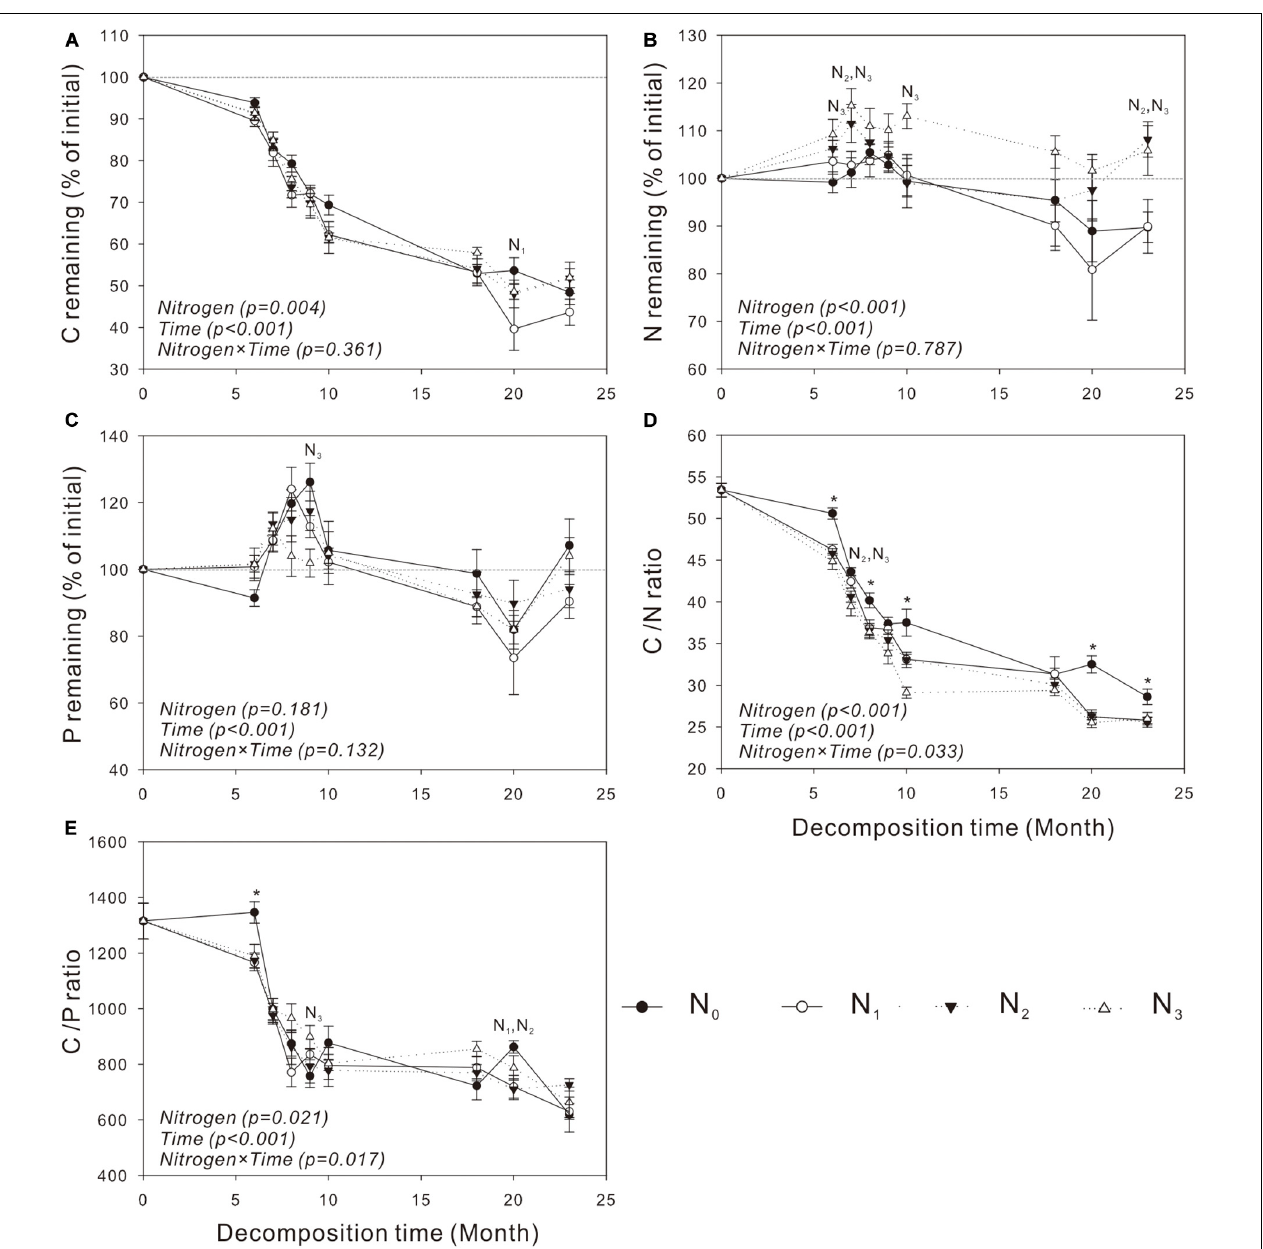
FIGURE 3 | Dynamics of the remaining C, N, and P and the C/N and C/P ratios in leaf litter of Spiraea trilobata (A–E) at different N addition levels during the whole experimental period. Text in italics indicates the effects of N and time, as well as their combined effects, based on the two-way ANOVA. N 1 , N 2 , and N 3 at each decomposition time indicate that the difference between the specified N treatments and the control (CK) was significant ( P < 0.05). The symbol * means that all N treatments were significantly different from the control. Error bars represent the standard deviations of the means ( n = 3). N 0 , control; N 1 , low N; N 2 , moderate N; and N 3 , high